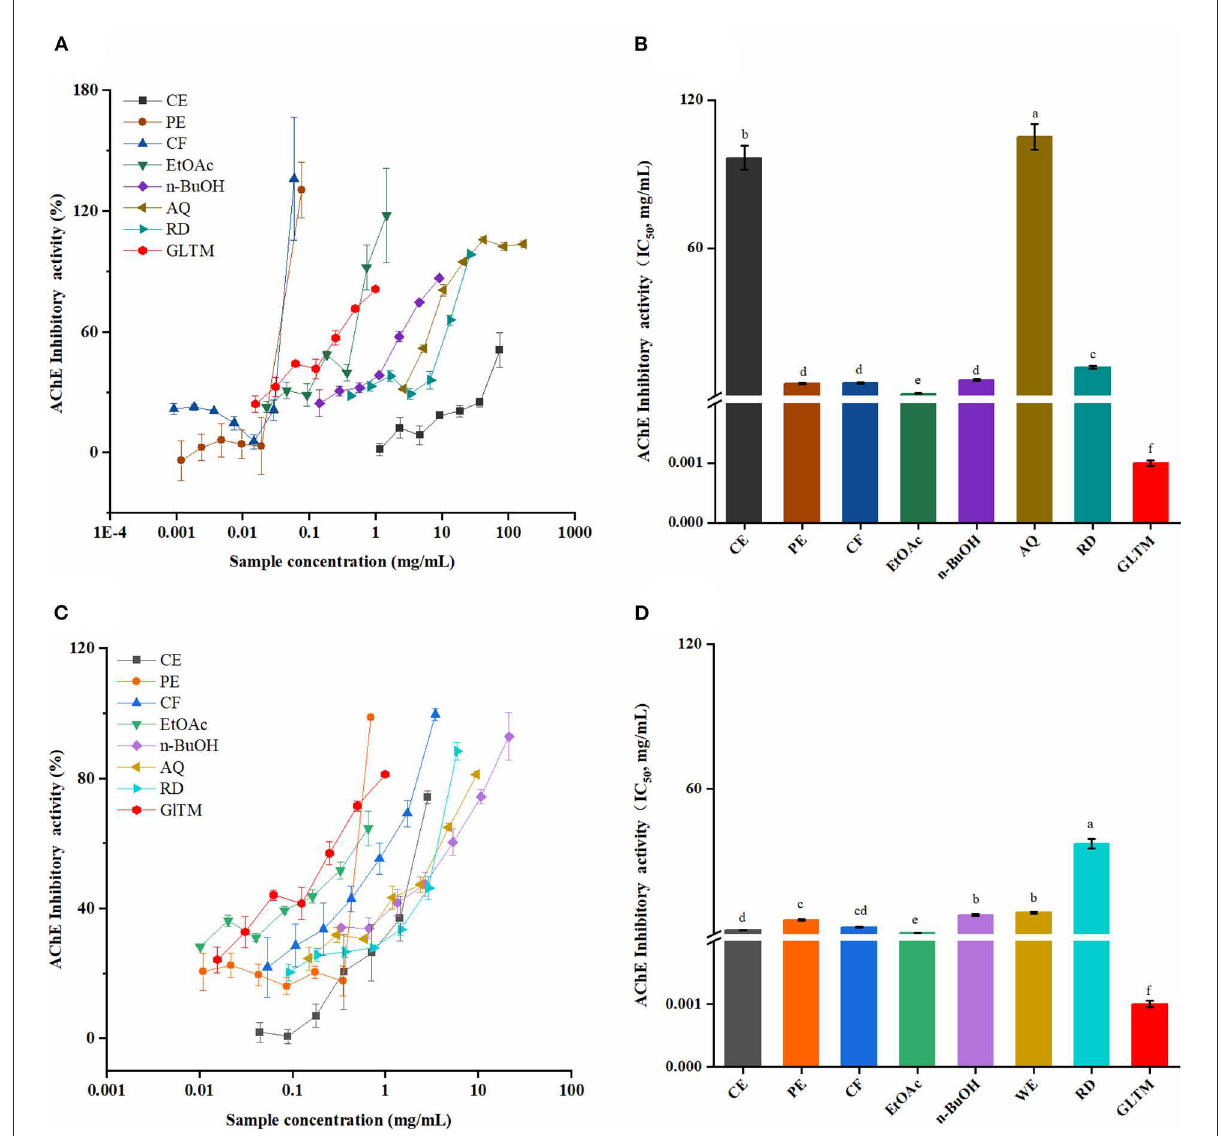
FIGURE5 The AChE inhibitory activities of the SOEs. (A,C) The inhibition ratio of AChE incubated with different concentrations of SOF and SOP; (B,D) The IC 50 values of SOF and SOP for AChE inhibition; SOEs, Stauntonia obovatifoliola extracts; SOF, Stauntonia obovatifoliola flesh; SOP, Stauntonia obovatifoliola pericarp. CE, crude extract; PE, Petroleum ether fraction; CF, chloroform fraction; EtOAc, ethyl acetate fraction; n-BuOH, n-Butanol fraction; AQ, aqueous phase residue; RD, residue; GLTM, galantamine; IC 50 , half maximal inhibitory concentration. The superscript letters indicate the statistical difference in rows in significant, p <